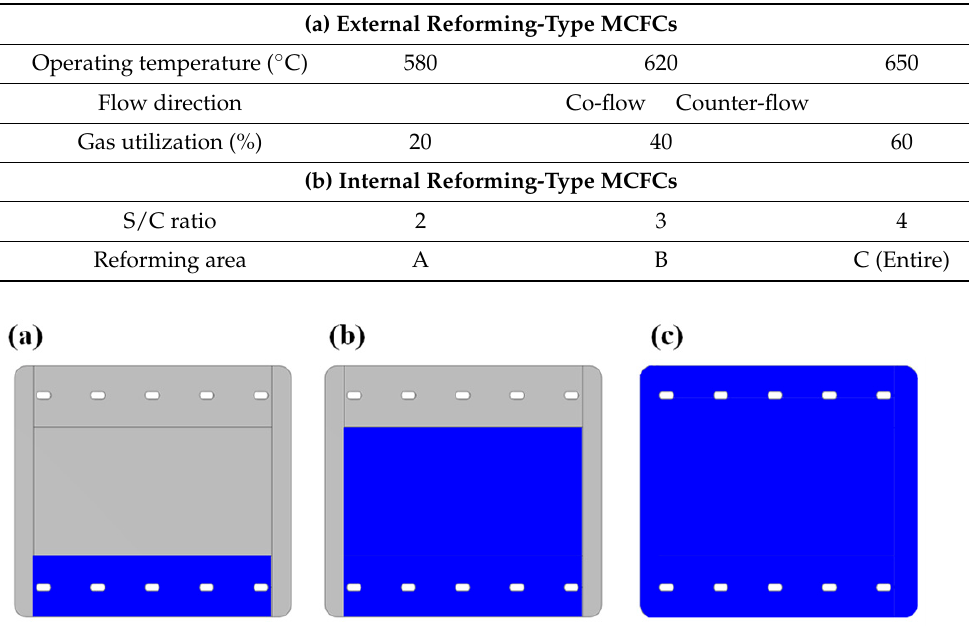
Figure 6. Schematic of reforming areas ( a ) A, ( b ) B, and ( c ) C. Table 1. Basic operating conditions of MCFCs.